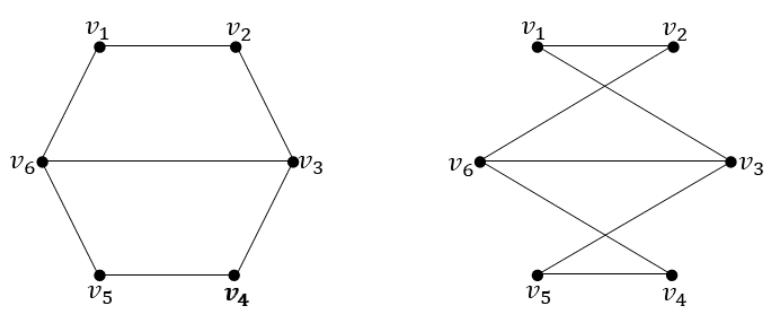
Figure 8. The graph J and its δ (cid:48) -complement J δ (cid:48)